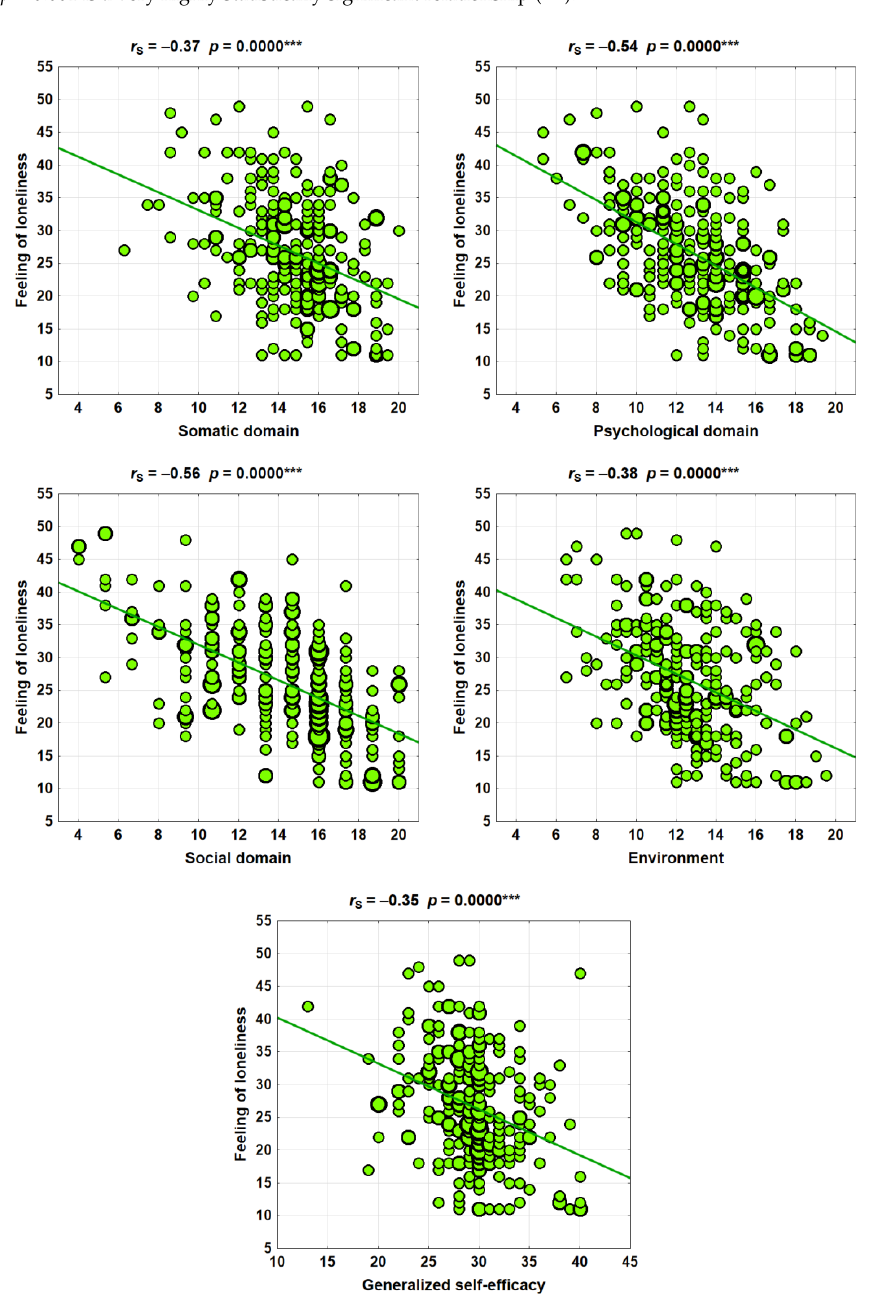
Figure 1. Feeling lonely, linked to quality of life in four areas: physical; psychological; social and environmental; and generalized self-efficacy. p < 0.001 is a very highly statistically significant relationship (***).